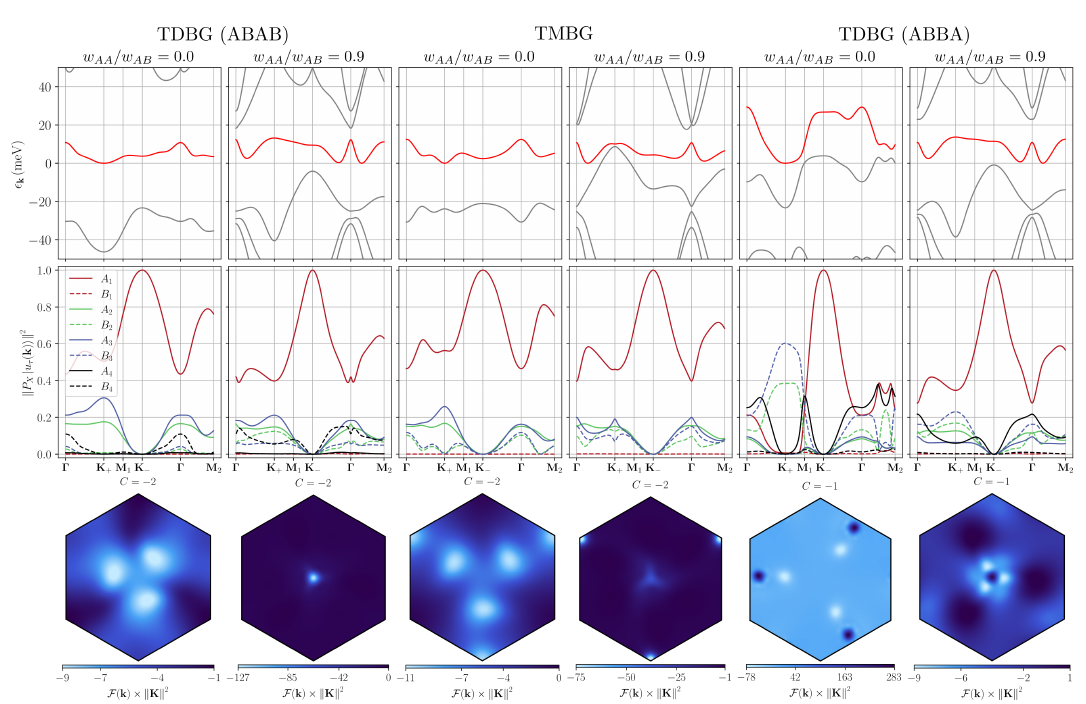
Figure 12: Band structure near the Fermi level (top), sublattice polarization (middle) and Berry curvature (bottom) of the τ “ ´ conduction band of ABAB stacked TDBG, TMBG as well as ABBA stacked TDBG at two representative values for w